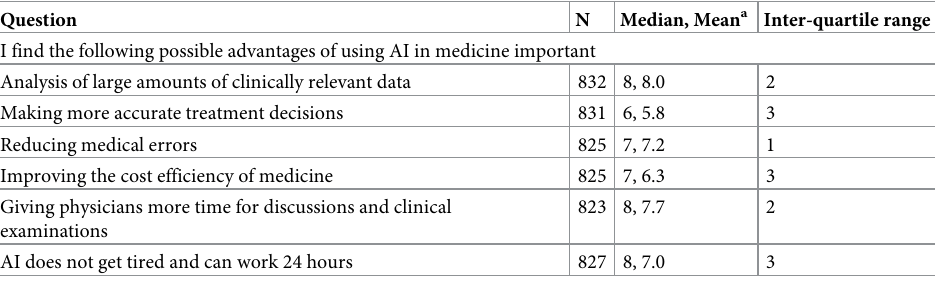
Table 3. Advantages of AI in